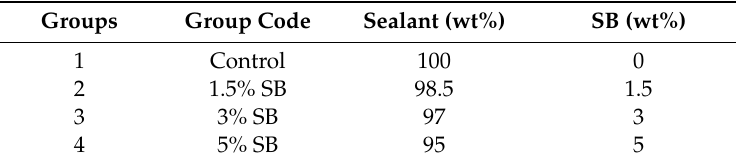
Table 1. Composition of materials in the control and experimental